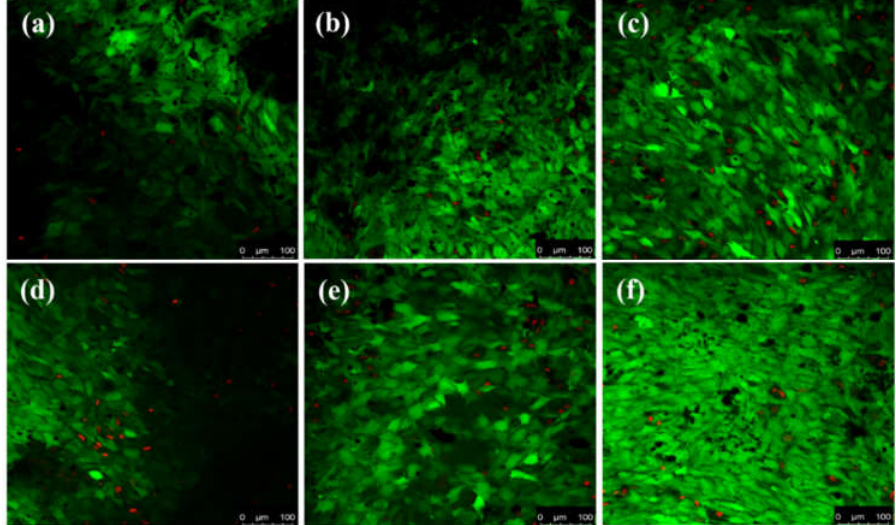
Figure 10. Viability of MG-63 cells grown on HAp samples. Viability was evaluated by cytoplasmic esterase enzyme activity and plasma membrane integrity, as measured by FDA-EtBr staining and confocal microscopy. The green color indicates live cells. ( a ) HAp1200, ( b ) HAp1250, and ( c ) HAp1300 samples after 5 days of culturing; ( d ) HAp1200, ( e ) HAp1250, and ( f ) HAp1300 samples after 7 days of culturing.